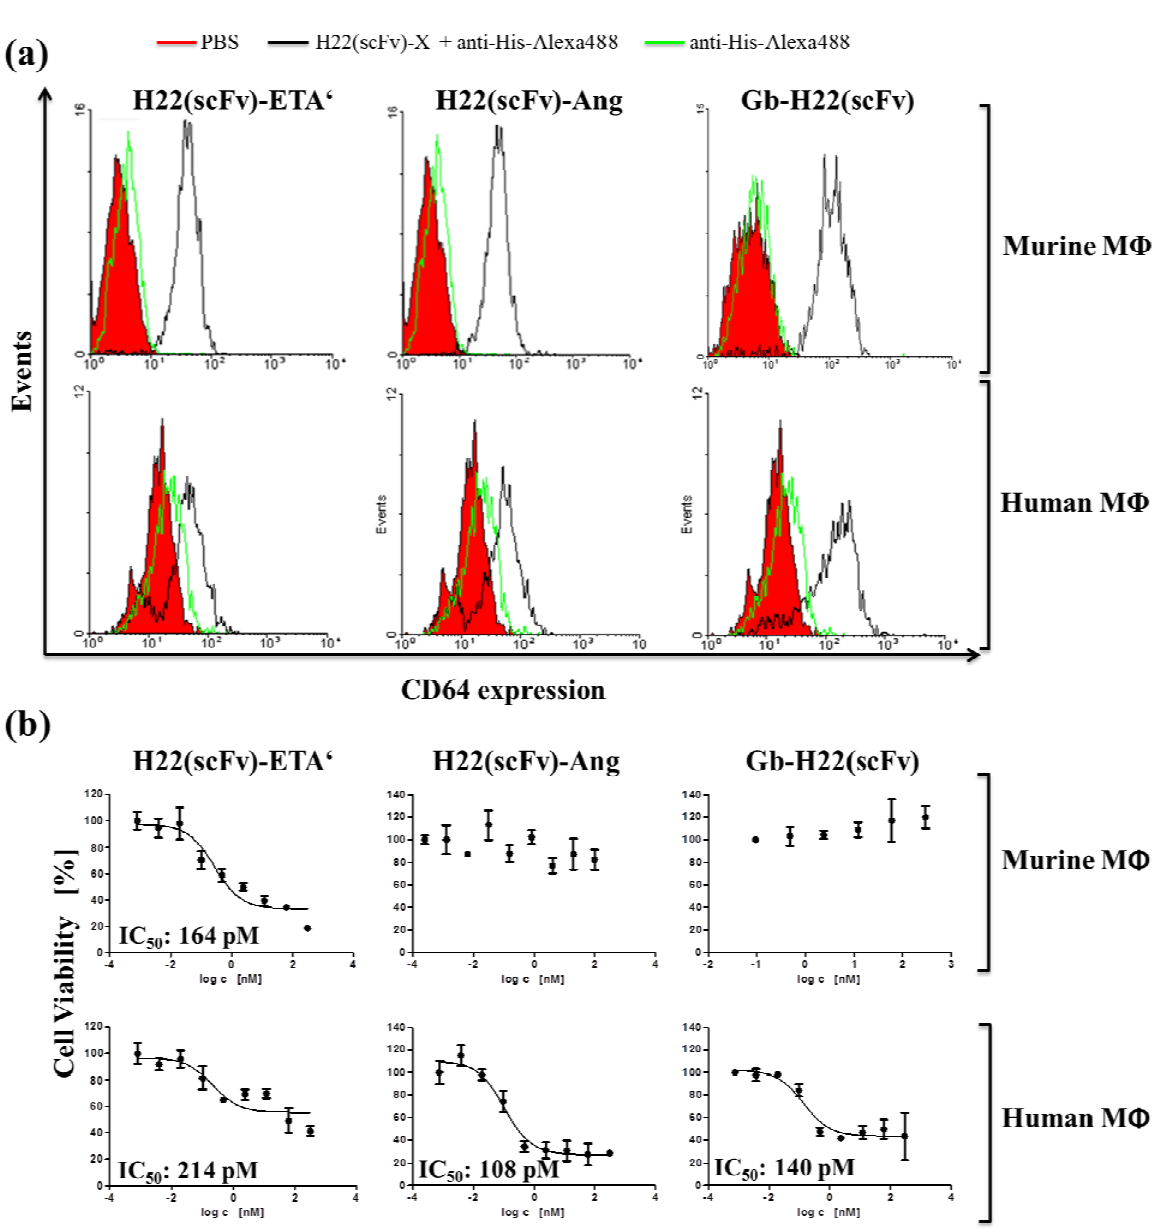
Figure 2. Binding ( a ) and cellular cytotoxicity ( b ) of H22(scFv)-based fusion proteins to hCD64-transgenic murine macrophages and human PBMCs-derived macrophages. Cell binding activity of 1 µM recombinant protein was analyzed by flow cytometry. Detection was performed using an anti-Penta-His-Alexa Fluor 488 antibody. Cellular cytotoxicity was assessed by a XTT assay. The concentration required to achieve 50% reduction of protein synthesis (IC ) relative to untreated control cells was calculated using GraphPad 50 Prism. All experiments were carried out in